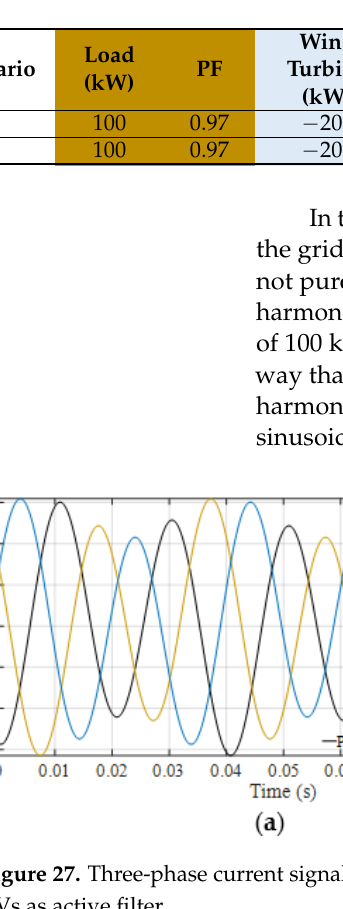
Figure 27. Three-phase current signals at the secondary side of the substation. ( a ) Deformed by harmonic and ( b ) operating EVs as active filter. Accordingly, the total harmonic distortion of the current (THDi) has decreased from nearly 22% in scenario 1 to the less than 4% in scenario 2 as shown in Figure 28a,b, respectively. To put it differently, this smart exploitation of the EVs could reduce the THDi to a value lower than 8% defined in EN 50160 standard.